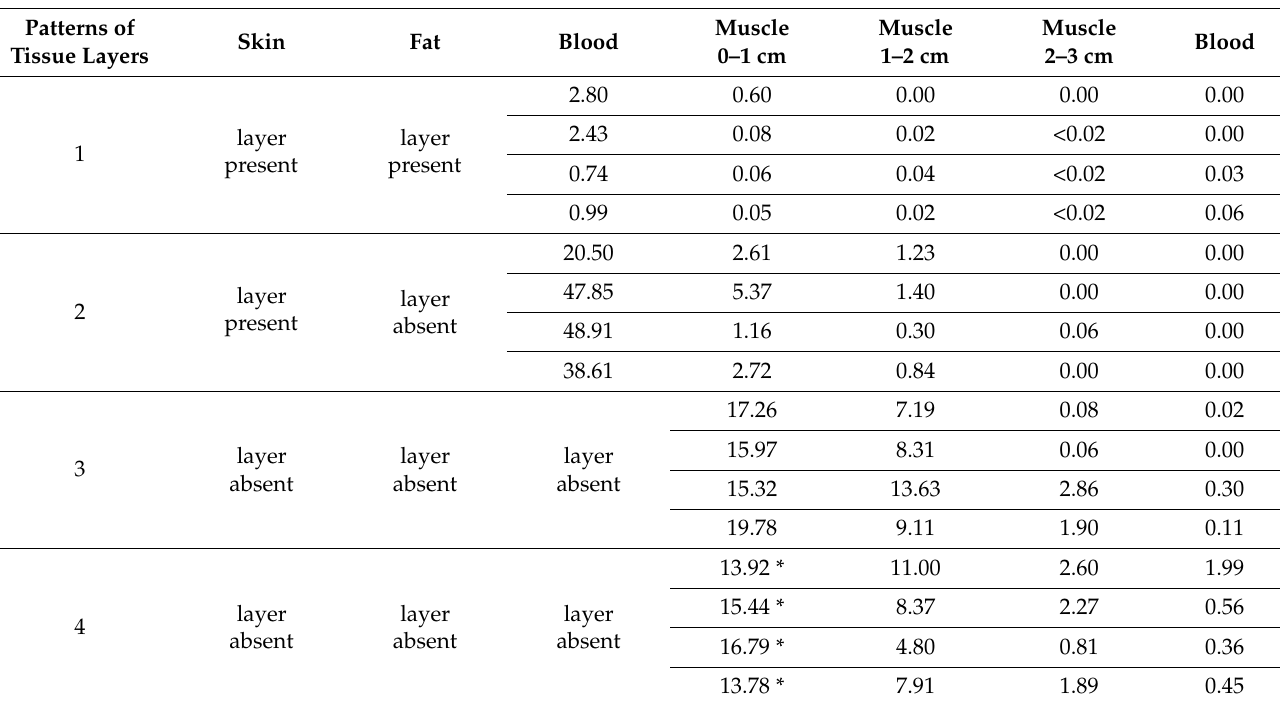
Table 2. Concentrations of HCN in blood (mg/L) and 3 muscle layers (mg/kg) after the 24 h exposure at +30 ◦